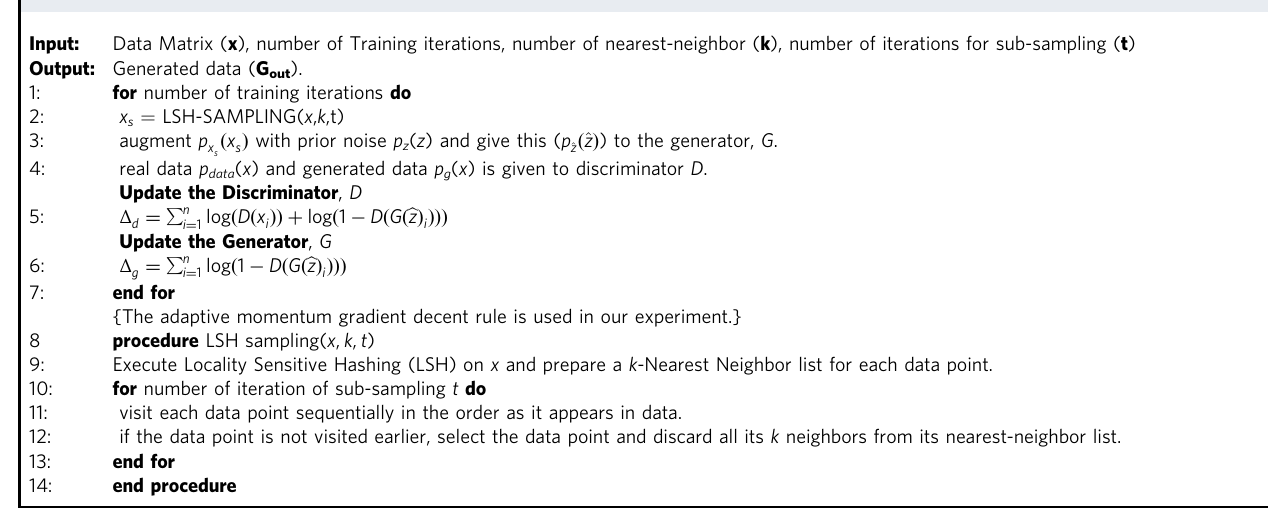
Table 2 Wasserstein distance between generated and real data distribution.